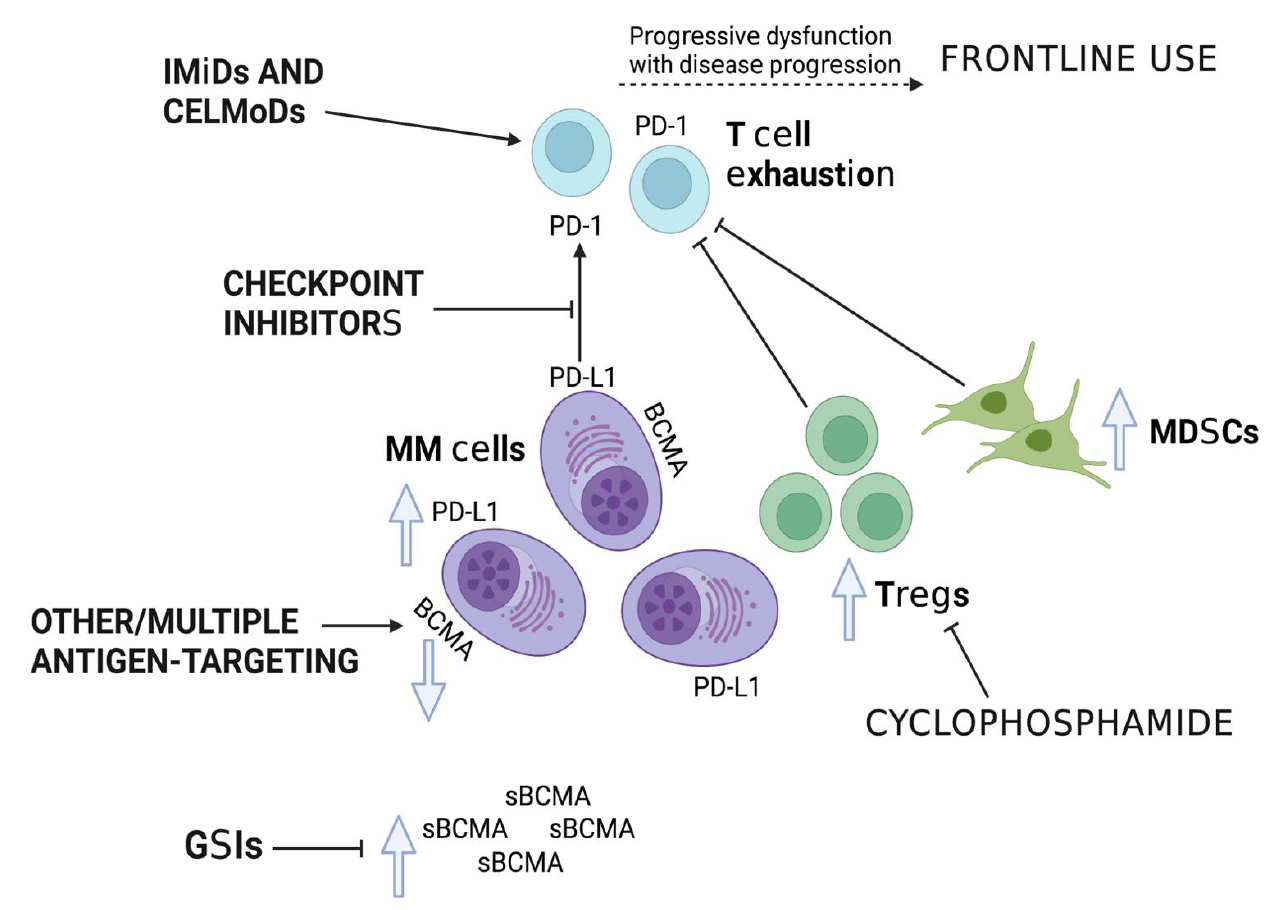
Figure 2. Approaches to harnessing the TME to improve the efficacy of BsAbs in MM.